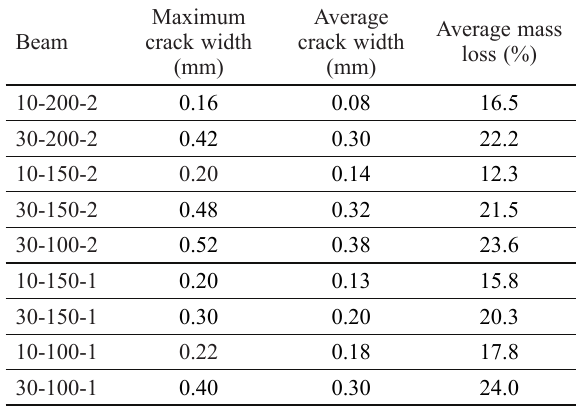
Fig. 5. Typical corrosion crack pattern Table 2. Corrosion crack width and mass